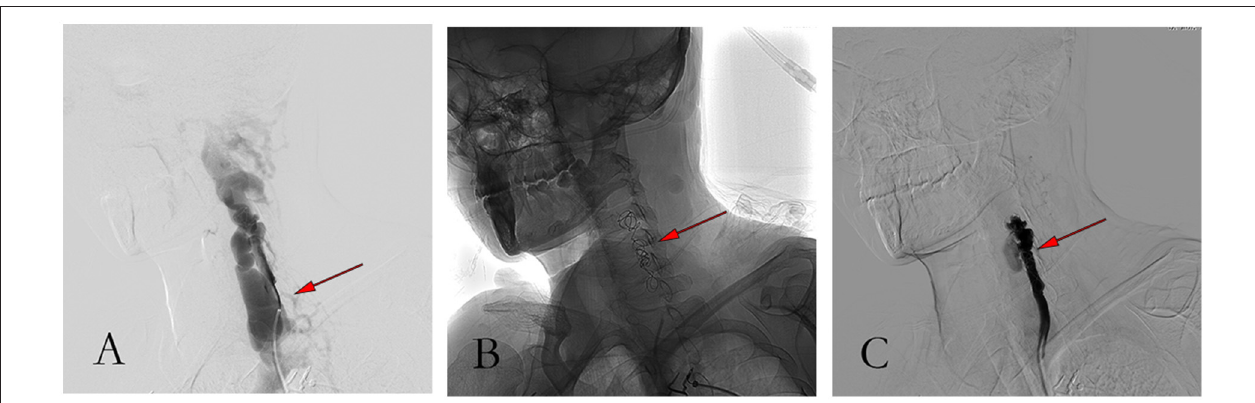
FIGURE 5 | Pictures of the procedure. (A) Angiography showed massive venous development before embolization; (B) Angiographic image after coil embolization; (C) Angiography showed good occlusion and less vein development after coil embolization.